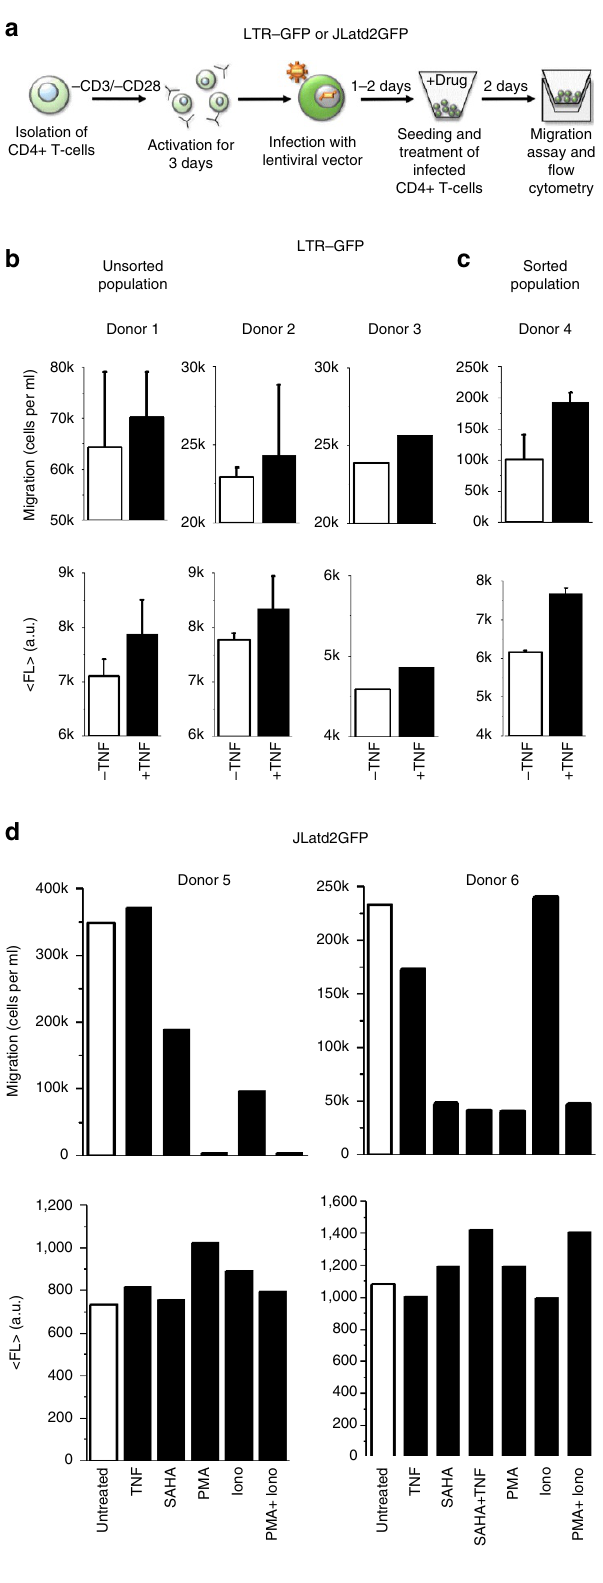
migration and fluorescence (Fig. 6d). This GFP þ infected and sorted population may represent actively replicating latent cells, that is, post reactivation. Although deficient in observing the transition of reactivation to a fully activated state, the sorted infected population allows for observation of modulated migra- tion and viral expression phenotypes. These behaviours resemble those of active primary cells reactivated from a resting latent state. Figure 6 | LTR-CXCR4 coupling and migratory behaviours of HIV- infected primary CD4 þ T-cells. ( a ) Primary CD4 þ T-cells are isolated from fresh human whole blood and stimulated with anti-CD3/anti-CD28 antibodies on the same day. After 3 days of stimulation, the cells are infected with concentrated lentivirus containing either HIV-1 LTR–GFP or the full-length HIV-1 (JLatd2GFP) for 2h by spinoculation. Next, CD4 þ T-cells are sorted for GFP-positive cells 1 day after infection or unsorted cells are used 1–2 days after infection. Sorted or unsorted CD4 þ T-cells are then seeded into V-bottom plates and treated with drugs for 2 days. Migration assays were carried out using a 96-well transwell chamber and expression of GFP was measured using flow cytometry. ( b ) 48h TNF treatment of unsorted LTR–GFP infected CD4 þ T-cells from three separate donors shows a correlated increase of both migration and mean fluorescence. Measurements using donor 1 and 2 were performed in duplicate and the average values and the s.e. are plotted. Only a single measurement was obtained from Donor 3. ( c ) GFP þ sorted LTR–GFP-infected CD4 þ T-cells show co-expression of LTR and CXCR4-migration after 48h of TNF treatment, consistent with the Jurkat cells. Error bars are s.e. ( d ) Sorted CD4 þ T-cells infected with JLatd2GFP display a decoupling from increased migration after 48h of TNF treatment. The decoupling of migration is relative to the primary CD4 þ T-cells infected with only LTR–GFP in b , c . In addition, cells treated with SAHA reduce migration consistent with the effect of HDACis in the Jurkat model in Fig. 5. PMA also displays a strong reduction of migration, as well as eliminating migration when combined with Ionomycin (Iono) similar to Fig. 5. For the second donor (donor 6), combination of PMA and Iono reduces enhanced Iono migration and SAHA reduces TNF migration. Measurements were performed on two separate